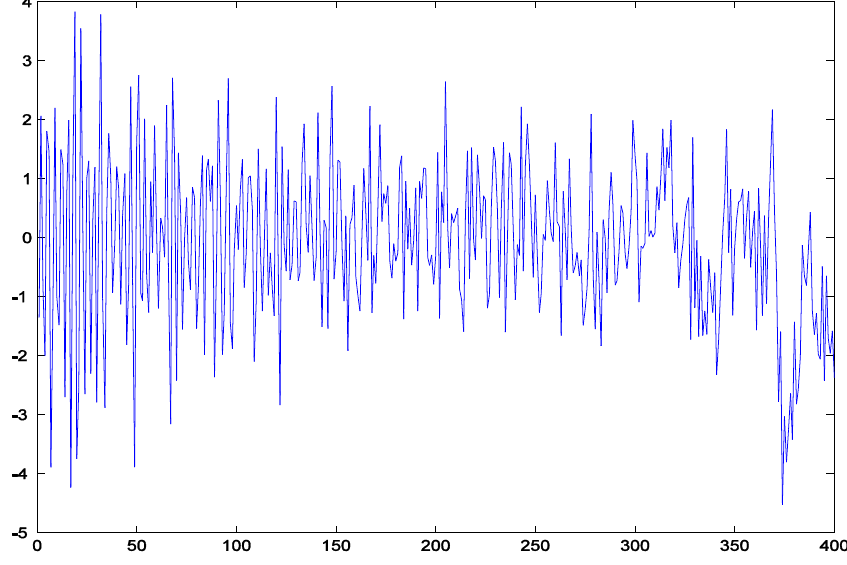
Figure A2. Plot of the data for one of the simulated tdAR(2) series for n = 400.